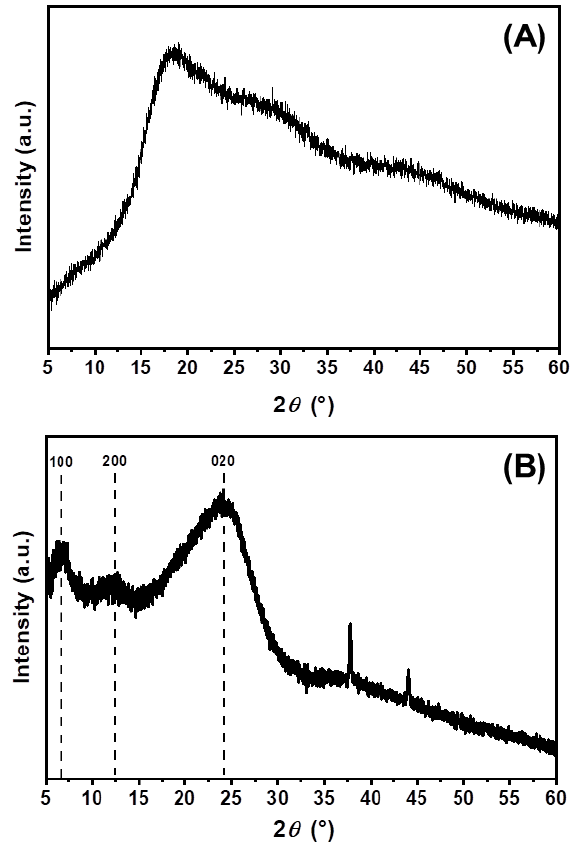
Figure 8. Powder X-ray diffraction patterns of ( A ) PThBr and ( B ) PEDOT.